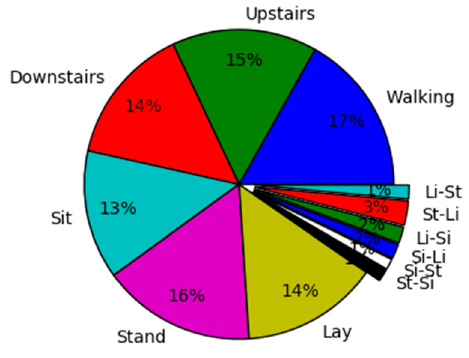
Figure 2. The statistics of posture data.